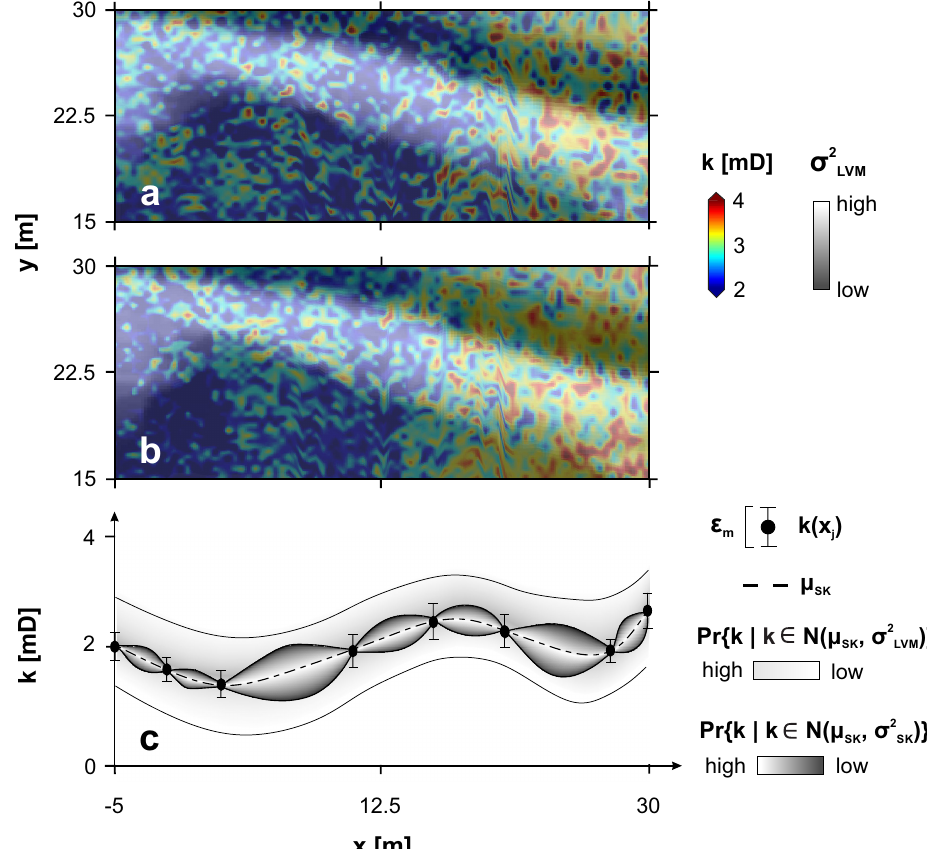
Figure 13. Top-view onto a representative simulation result of DSS ( a ) and LVM-DSS ( b ) superimposed by a gray-scale representation of the LVM with an opacity of 0.6. It is evident that the LVM-based algorithms’ heterogeneity is highest in that area of the LVM in which it provides the highest local variance as well. The conventional approach, however, does not reflect the expected variance in space. ( c ) Conceptual illustration showing the spatial distribution of the constraining measurements k ( x j ) and the spatial relationship between the simple kriging estimate µ SK with the measurement error (cid:101) m and the two parameters used to simulate k in this study namely σ 2 and σ 2 . Pr stands for the probability LVM SK of k under the condition that k belongs to the Gaussian distribution described by µ SK together with either σ 2 or σ 2 LVM SK